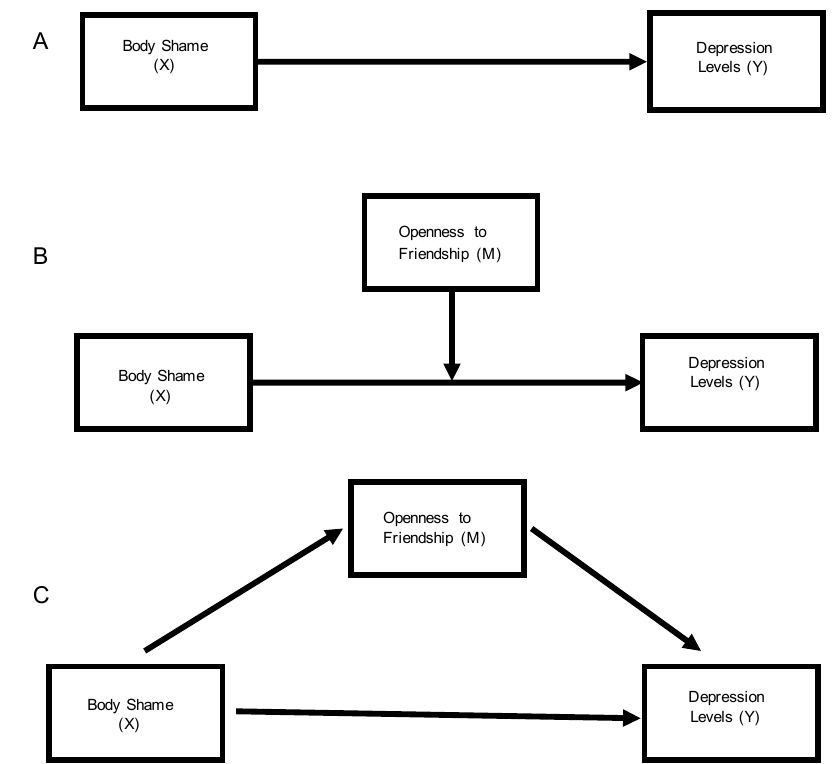
Figure 1. Path diagrams for ( A ) the total effect of body shame on depressive levels; ( B ) the moderated effect of openness to friendship; and ( C ) the mediated effect of body shame on depressive levels through openness to friendship.